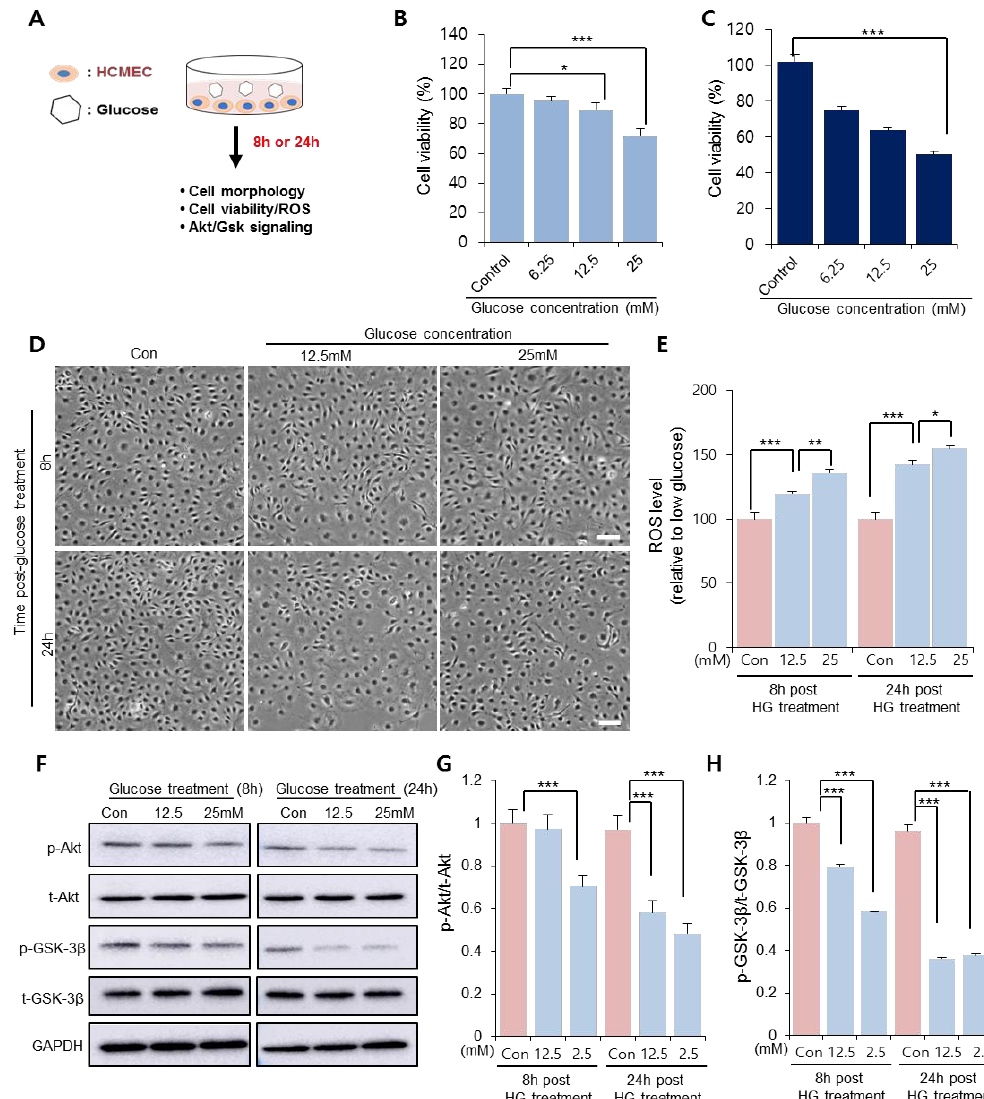
Figure 1. HG conditions impair viability of cardiac microendothelial cells. ( A ) Experimental scheme for glucose treatment. CMECs were exposed to HG conditions. ( B , C ) Cell viability and cellular morphology were observed at 8 and 24 h after treatment. Cell viability of CMECs was evaluated via WST-1 assays at ( B ) 8 and ( C ) 24 h. ( D ) Cellular shape was observed. Scale bar: 100 µm. ( E ) Reactive oxygen species production was quantified from supernatants of CMECs treated with HG. ( F – H ) p-Akt and p-GSK- 3β were detected and represented as values relative to total Akt and GSK- 3β, respectively. Expression levels were represented relative to that of the control. Values of p < 0.05 were considered significant (* p < 0.05, ** p < 0.01, *** p < 0.001). The data are expressed as the mean ± standard deviation of three independent experiments. CMECs, cardiac microvascular endothelial cells; HG, high glucose; Akt, protein kinase B; p-Akt, phosphorylated Akt; t-Akt, total Akt; GSK- 3β, glucose synthase kinase 3 beta; GAPDH, glyceraldehyde -3-phosphate dehydrogenase; Con, control growth media.